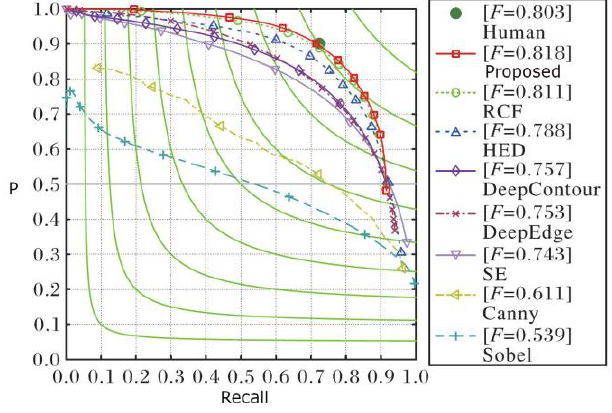
Figure 8. Evaluation results on BSDS500